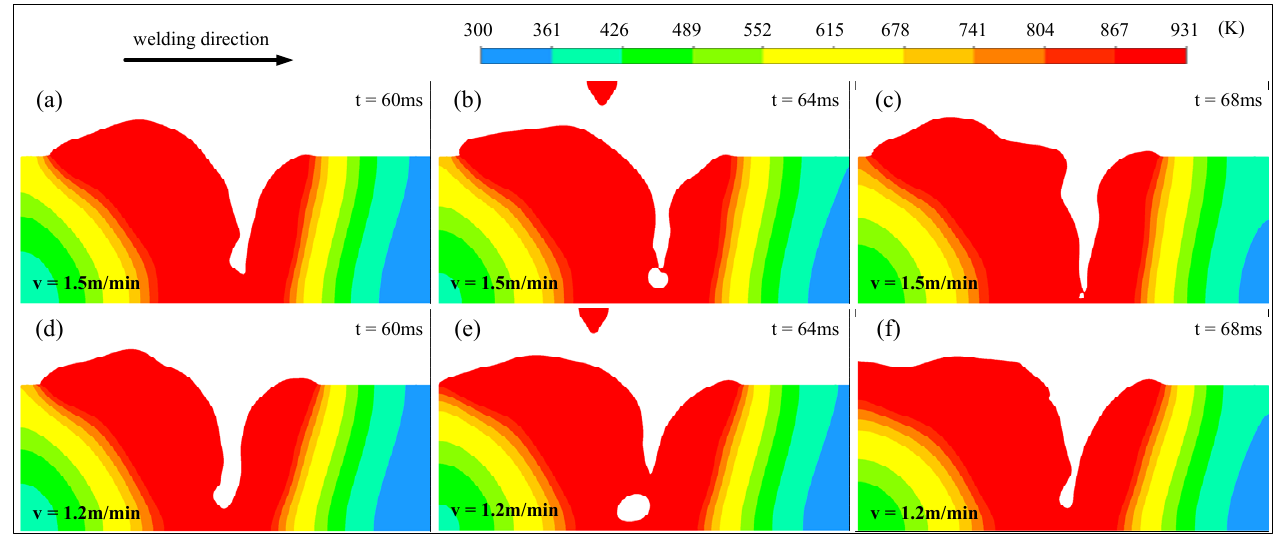
Figure 10. Simulation results of temperature field in keyhole evolution process under different welding current.